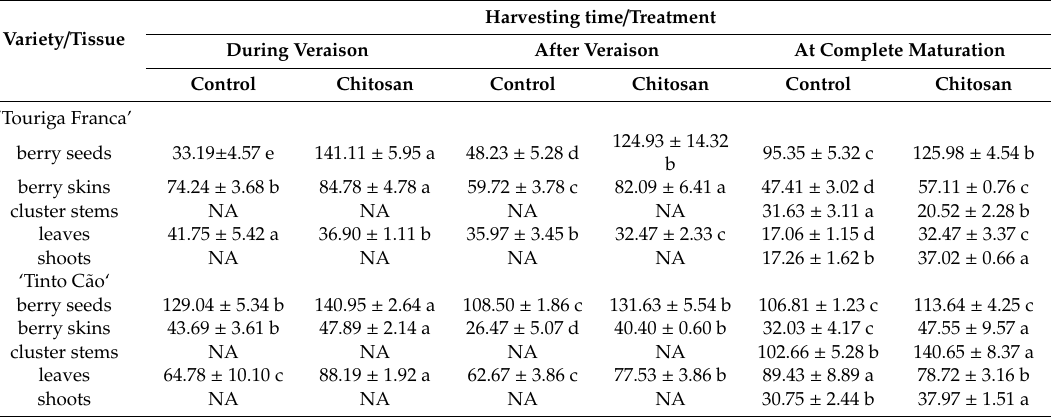
Table 4. The total tannin